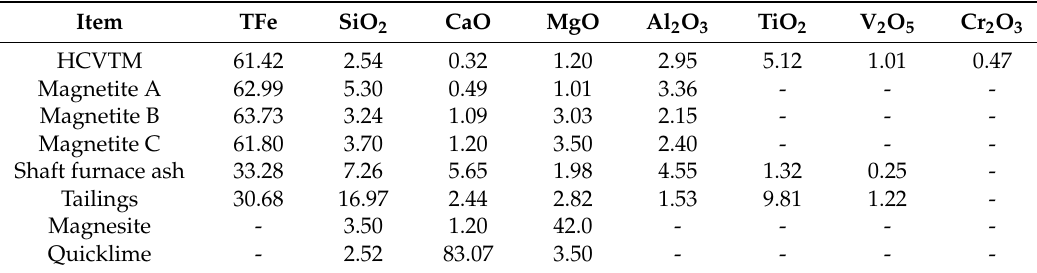
Table 1. Chemical compositions of the raw material (%).